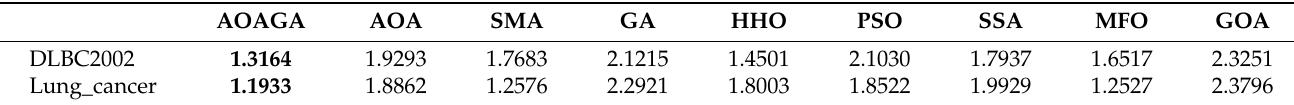
Table 14. Real Application: Standard deviation of the fitness value.